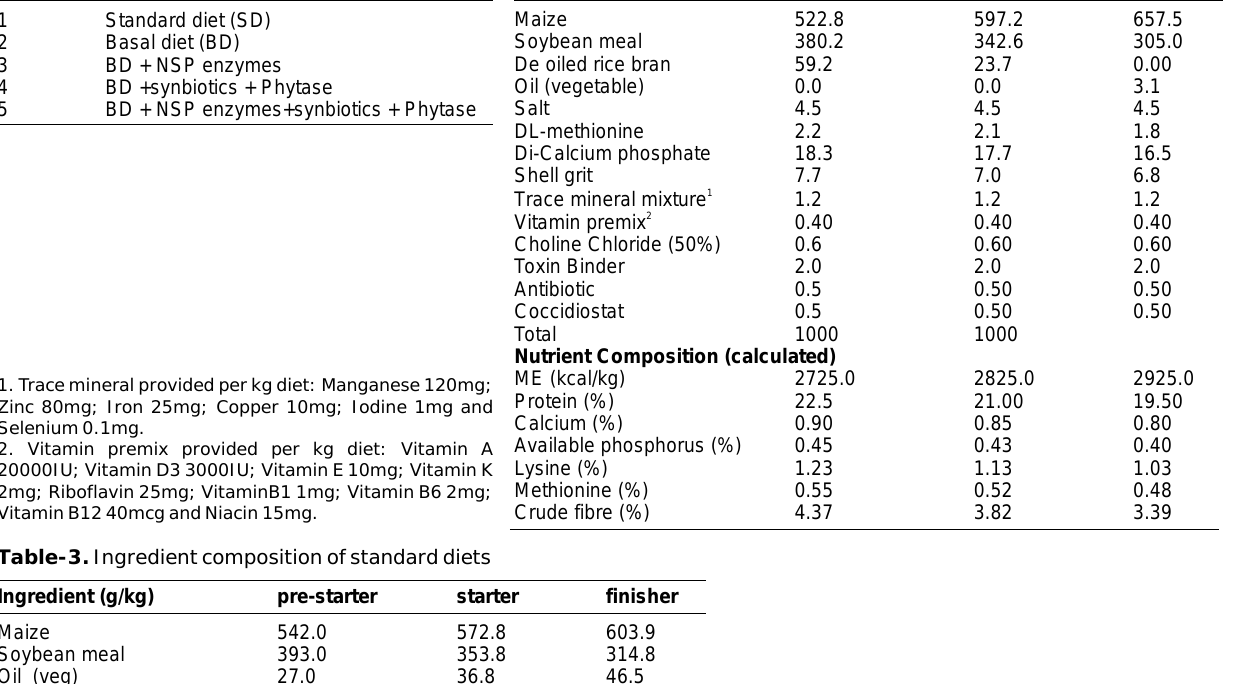
Table-1. Details of experimental diets Table-2. Ingredient composition of Basal diet (BD) Diet no.